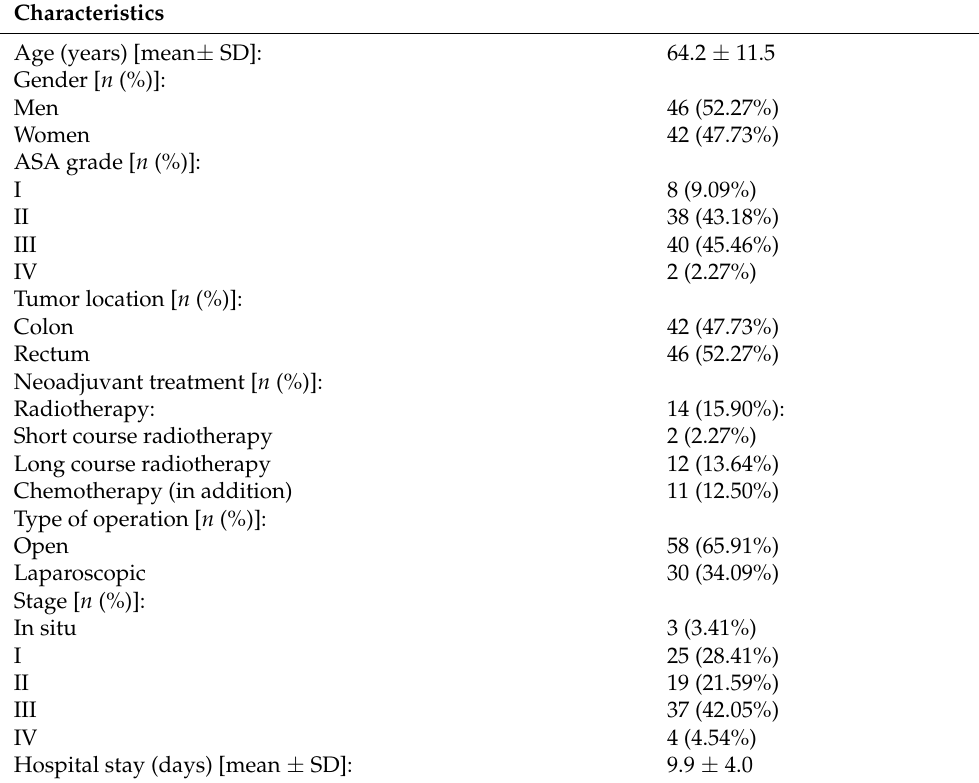
Table 1. Demographic and clinical data.